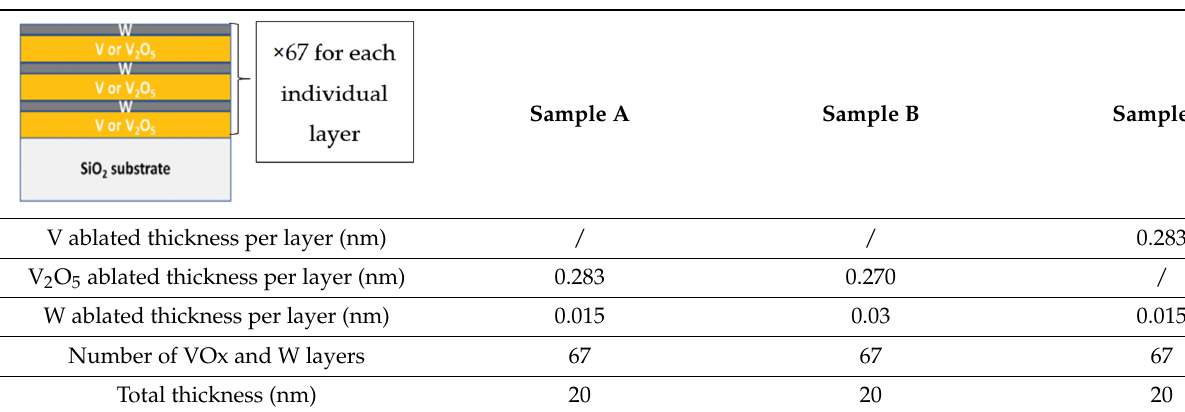
Table 1. Condition of deposited multilayers using pulsed laser deposition. The ablated thickness per layer and the number of individual layers were adjusted to obtain three different W contents (next investigated using XPS).